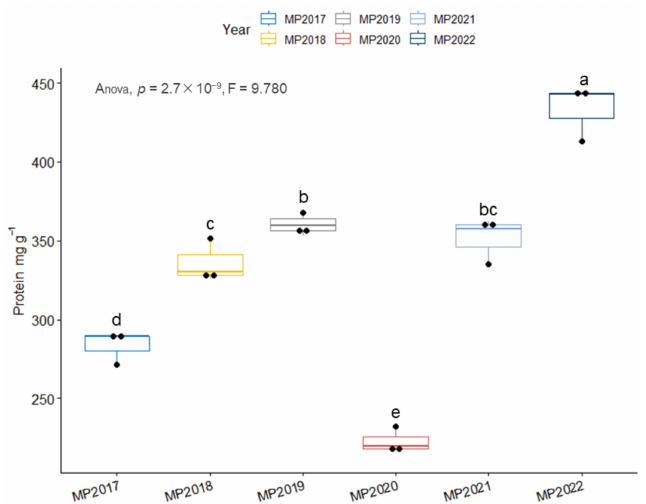
Figure 3. Protein content of M. polymorpha . Protein content decreased dramatically starting in the second year of storage and remained largely steady for the following four years, with no significant correlation between protein content and storage period ( p = 0.323 > 0.05). At the 0.05 level of significance, lowercase letters a through e denote the findings of the study of the significance of differences between multiple samples, based on Duncan’s multiple range test, with a being the most significant results and e denoting the least